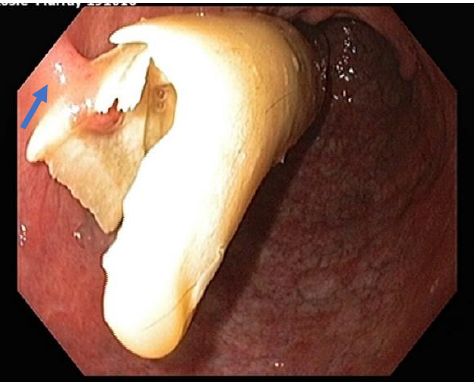
Figure 2. Uteroscopic view of the uterine lumen showing a fetal femur protruding from the endometrium within the right horn of the uterus. A partial adhesion to the endometrium can be seen on the left side of the image (blue arrow).